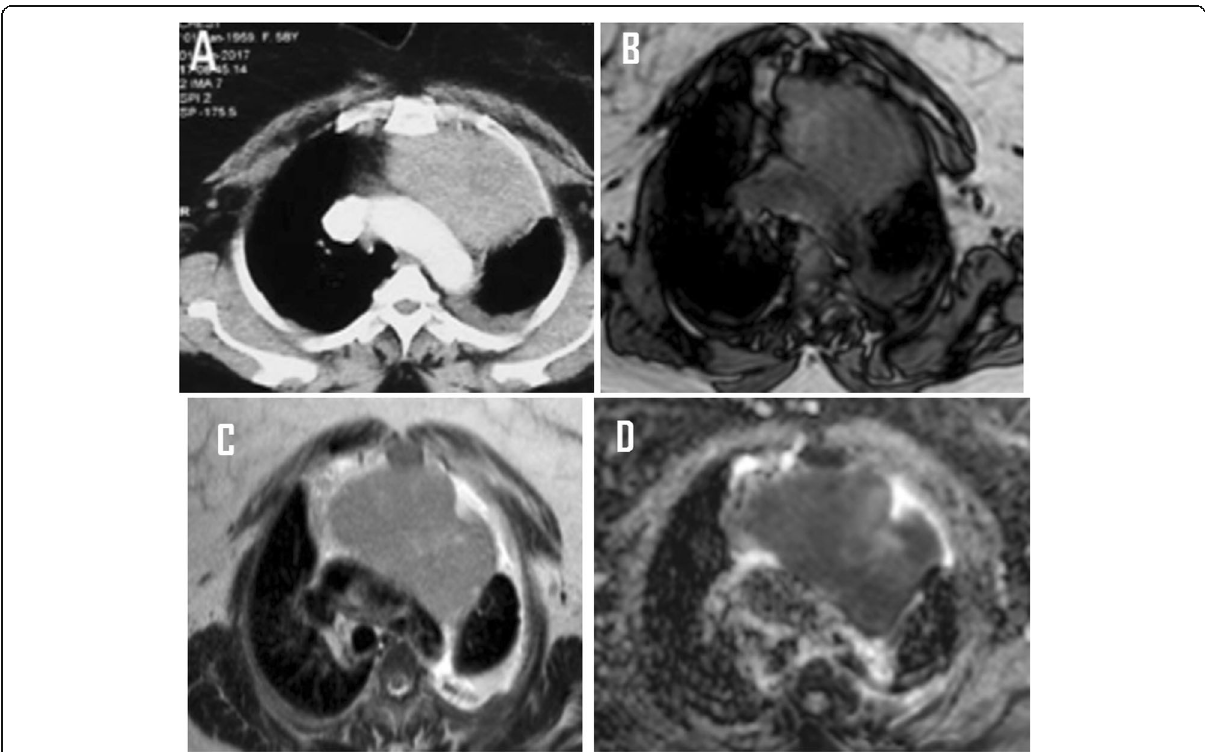
Fig. 4 Fifty-eight-year-old female presenting with cough and dyspnea. a Axial contrast-enhanced CT chest mediastinal window shows a well- defined homogenously enhancing anterior mediastinal soft tissue mass. MRI was done, and axial chemical shift sequences show no suppression on the out-phase ( b ) compared to the in-phase images ( c ) with CSR of 1.13. In diffusion-weighted images, ACD map ( d ) shows restricted diffusion with ADC value = 0.9. Histopathological assessment revealed